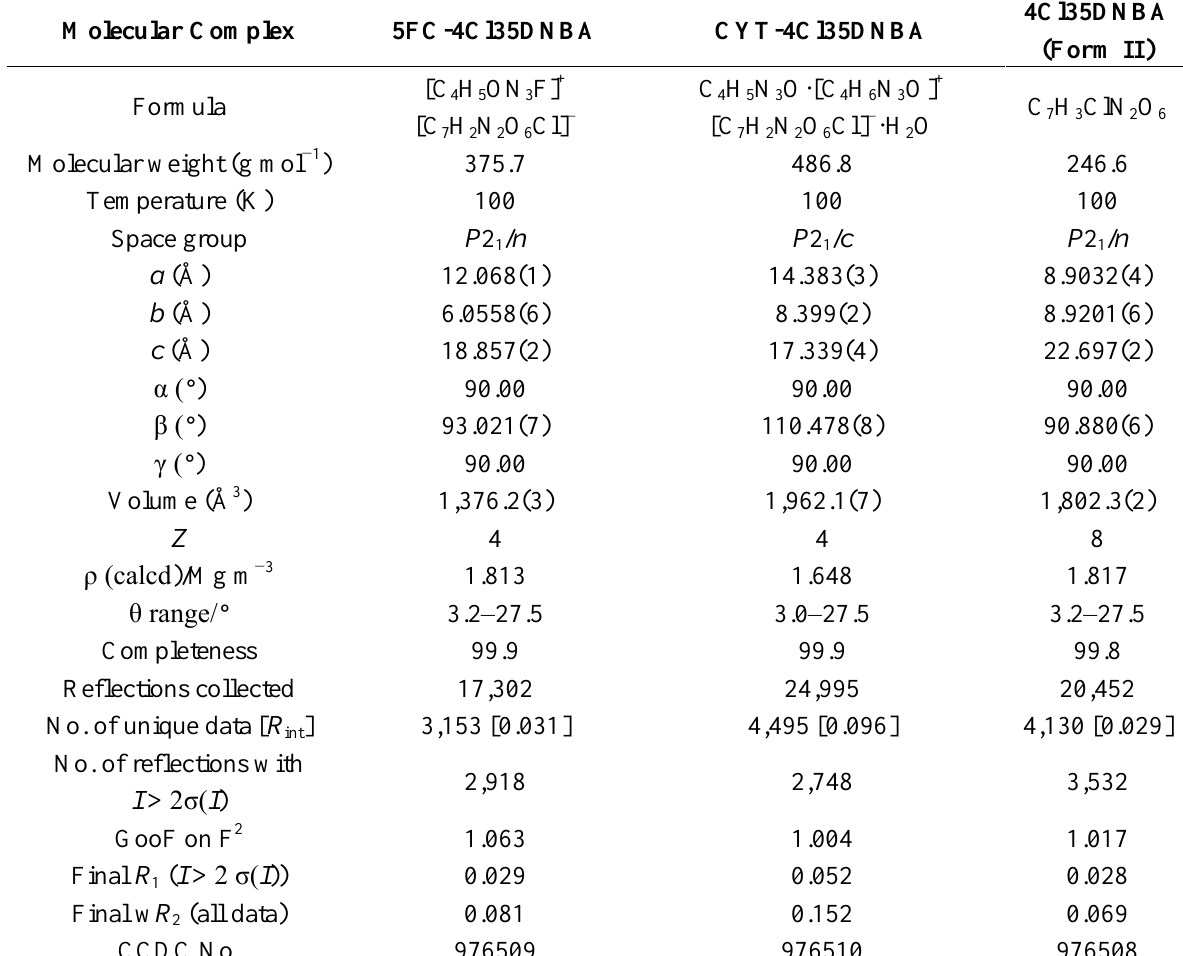
Table 2. Crystallographic information on two new multi-component molecular complexes of 4Cl35DNBA and a new polymorphic form of